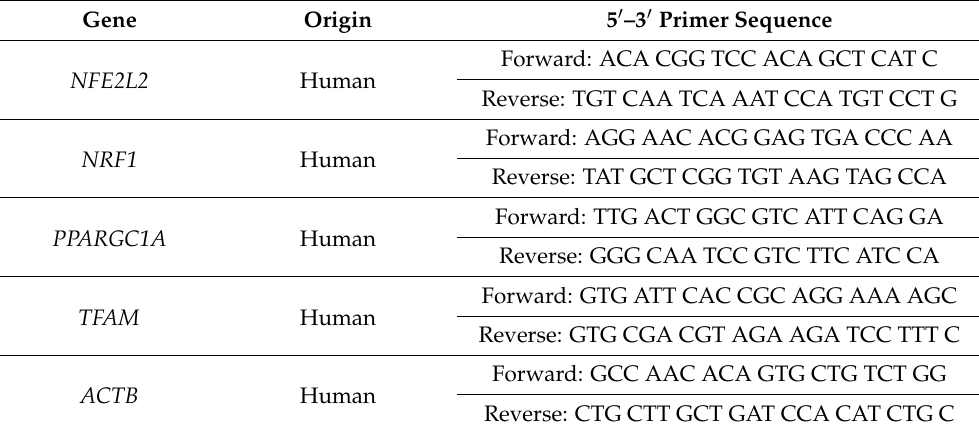
Table 1. RT-qPCR